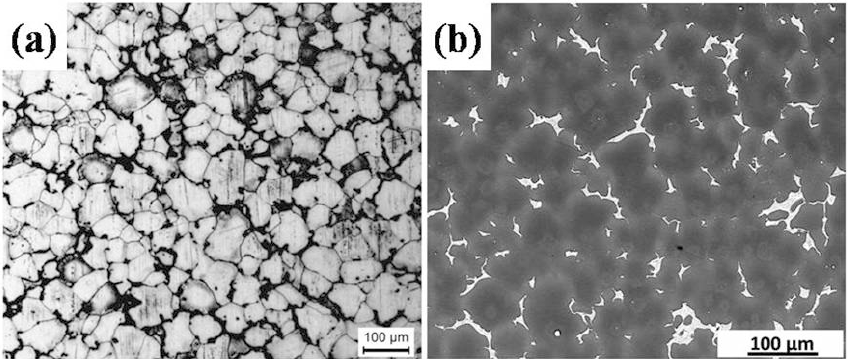
Figure 1. ( a ) OM and ( b ) BSE images of the BM specimen.